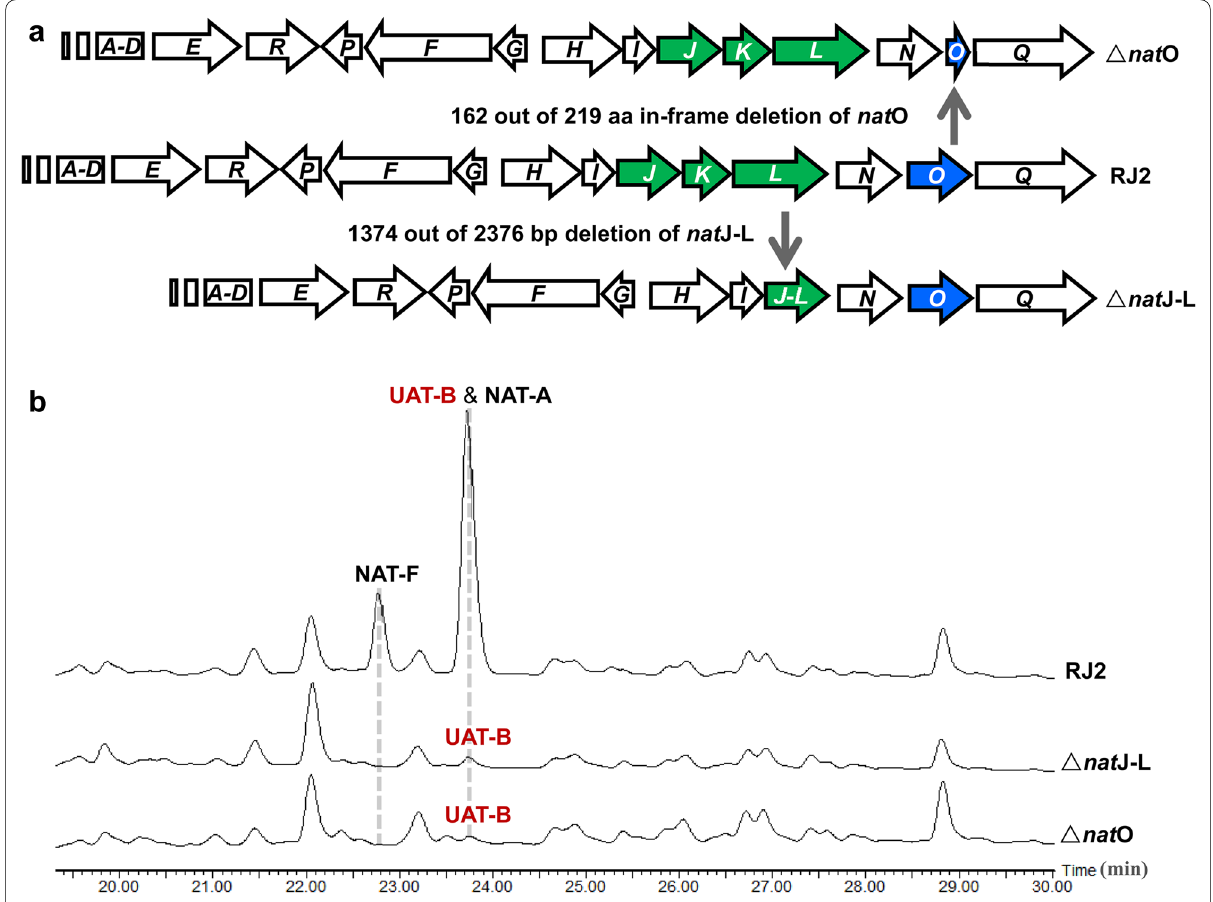
Fig. 2 Schematic diagrams of generating Δ nat O and Δ nat J‑L from RJ2 ( a ). HPLC analysis of UAT‑B, NAT‑A and NAT‑F from the fermentation extracts of the parent strain RJ2 and the mutants Δ nat O and Δ nat J‑L ( b ). The data is displayed with UV320